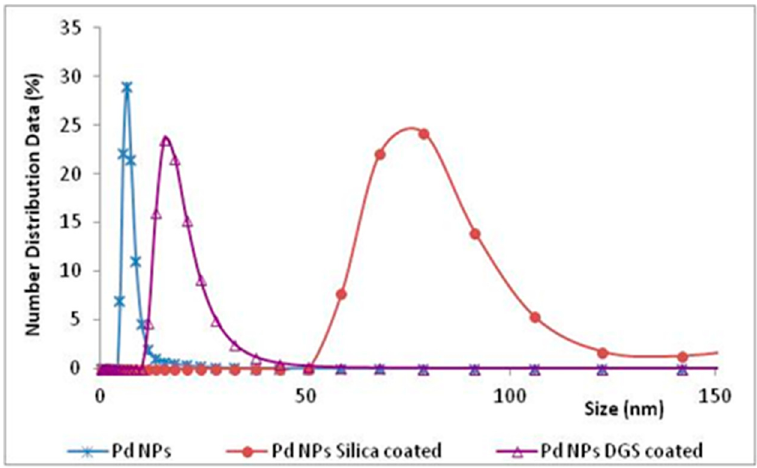
Figure 9. DLS spectra of Pd NPs solution (8 nm); DGS-coated Pd NPs (16 nm); silica-coated Pd NPs (80 nm).